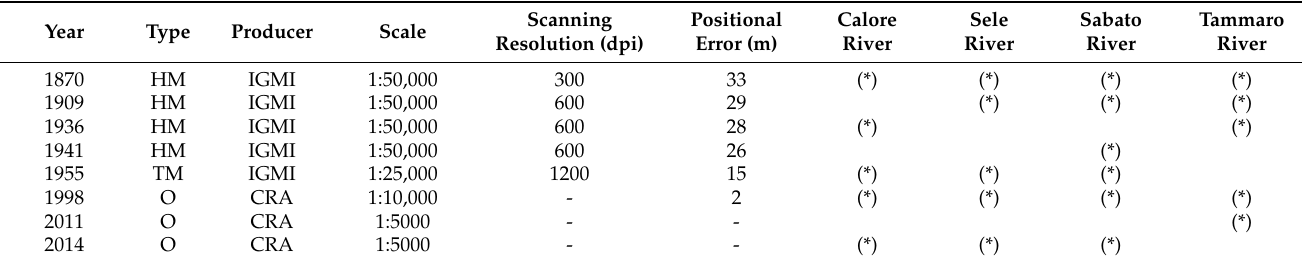
Table 3. Main characteristics of the used materials. Legend–HM: historical topographic maps; TM: more recent topographic maps; O: orthophotos; IGMI: Italian Geographic Military Institute; CRA: Campania Regional Authority. Positional errors were calculated according to Slama et al. [38] and Taylor [39]. Symbol (*) indicates which maps and orthophotos were used for the geomorphological analysis of each studied